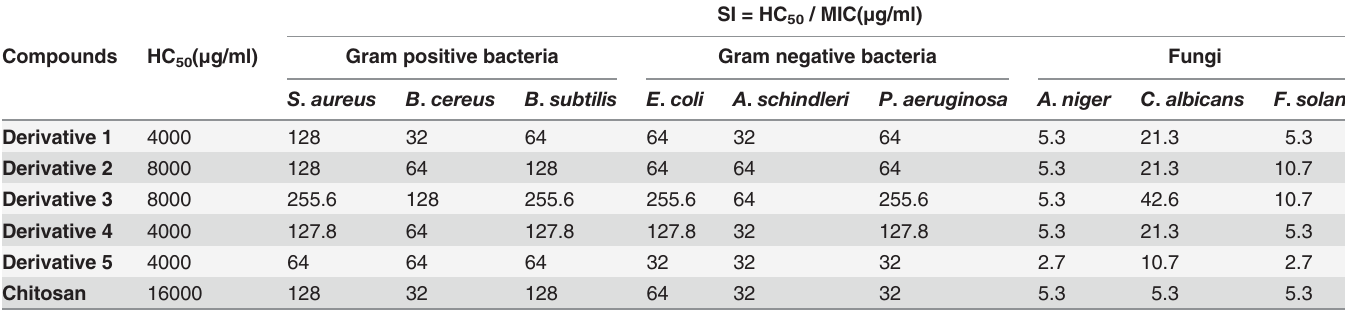
Table 4. Hemolytic activity of chitosan and derivatives. (n =